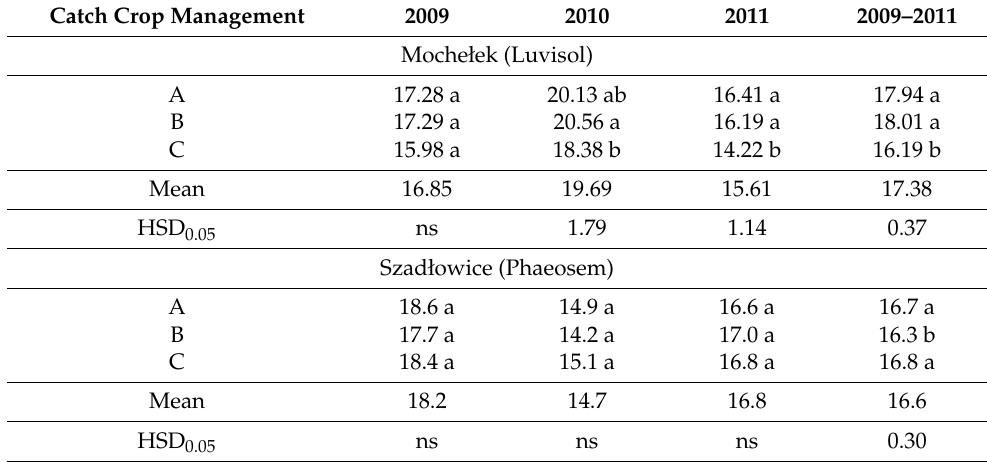
Table 7. Content of nitrogen in spring barley grain (g kg − 1 ) depending on a catch crop management. Catch Crop